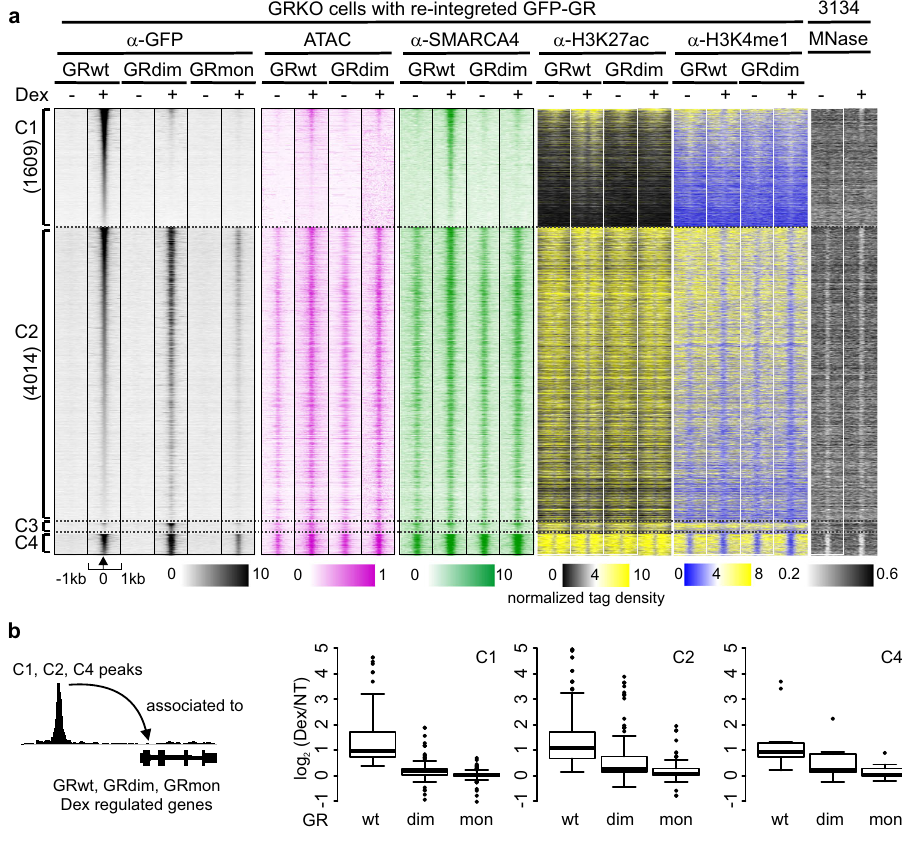
Fig. 2 Chromatin binding of GRwt, GRdim and GRmon. a Comparison of GRwt, GRdim, and GRmon binding reveals four clusters, C1 – C4; C1 GRwt speci fi c; C2 shared by GRwt and GRdim; C3 GRdim speci fi c; C4 shared by all three. Heat maps represent ChIP-seq, ATAC-seq, MNase-seq data as indicated. Each heat map represents ±1 kb around the center of the GR peak. Treatment indicated on top; binding intensity scale noted below on a linear scale. Heat maps sorted based on GRwt binding intensity, except C3 which is sorted on GRdim binding intensity. All heat maps normalized to 10 million reads, and further to local tag density. b C1, C2 and C4 sites are associated with nearest Dex up-regulated gene based on linear proximity. The up-regulated genes are from a composite list from the three cell lines, n = 195 genes. Box plots represent the overall log 2 fold change (Dex/NT) of genes in the respective cell line to called ChIP peaks from each cluster. No association of Dex up-regulated genes observed with C3 peaks. Box plots were generated with Tukey method with interquartile range (IQR) depicting the 25th, 50th and 75th percentile as box with the median as black bar. The whiskers extend 1.5xIQR beyond the box, and outliers depicted as circles extend beyond the 1.5xIQR. Source data are provided as a Source Data fi